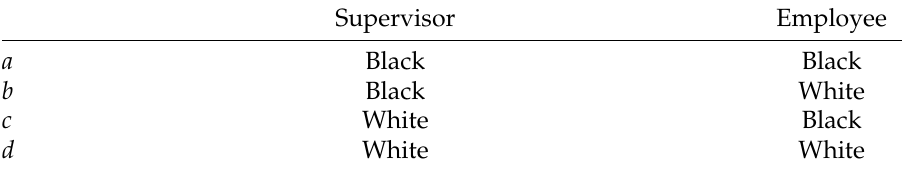
Table 4: Experiment 2